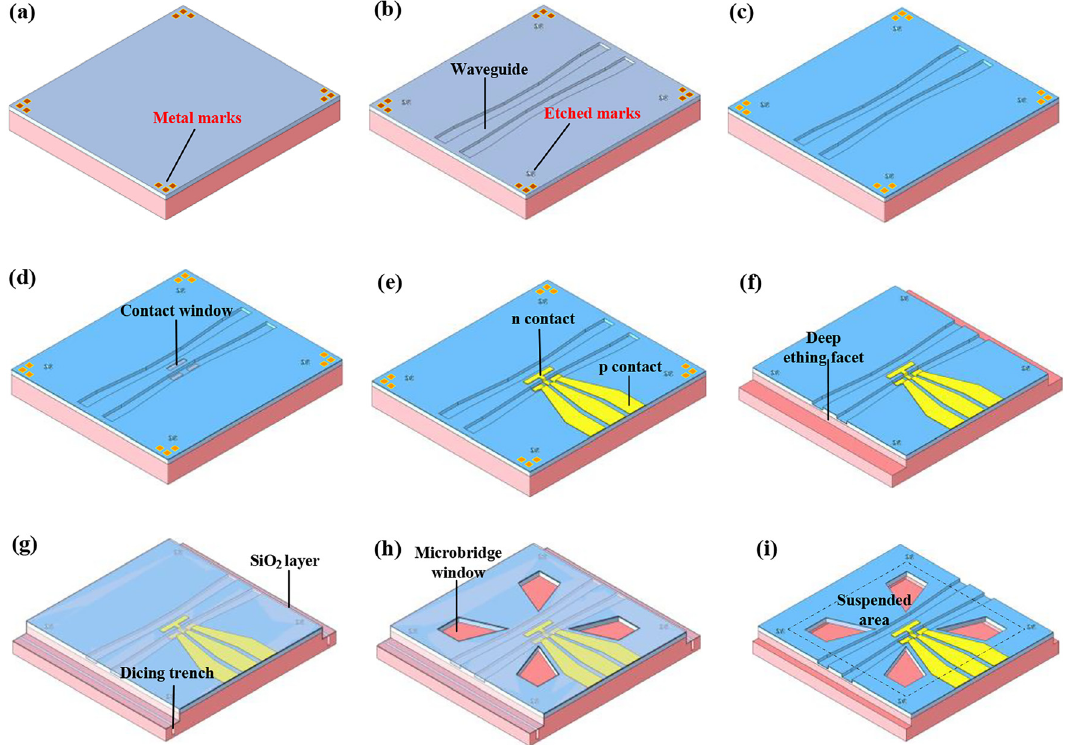
Figure 2: The schematic diagram of the fabrication process. (a) Metal marks fabrication; (b) waveguide lithography and etching; (c) deposition of passivation layer; (d) contact window lithography and etching; (e) contact evaporation; (f) deep etching; (g) wafer dicing and protecting layer deposition; (h) microbridge window etching; (i) wafer splitting and wet